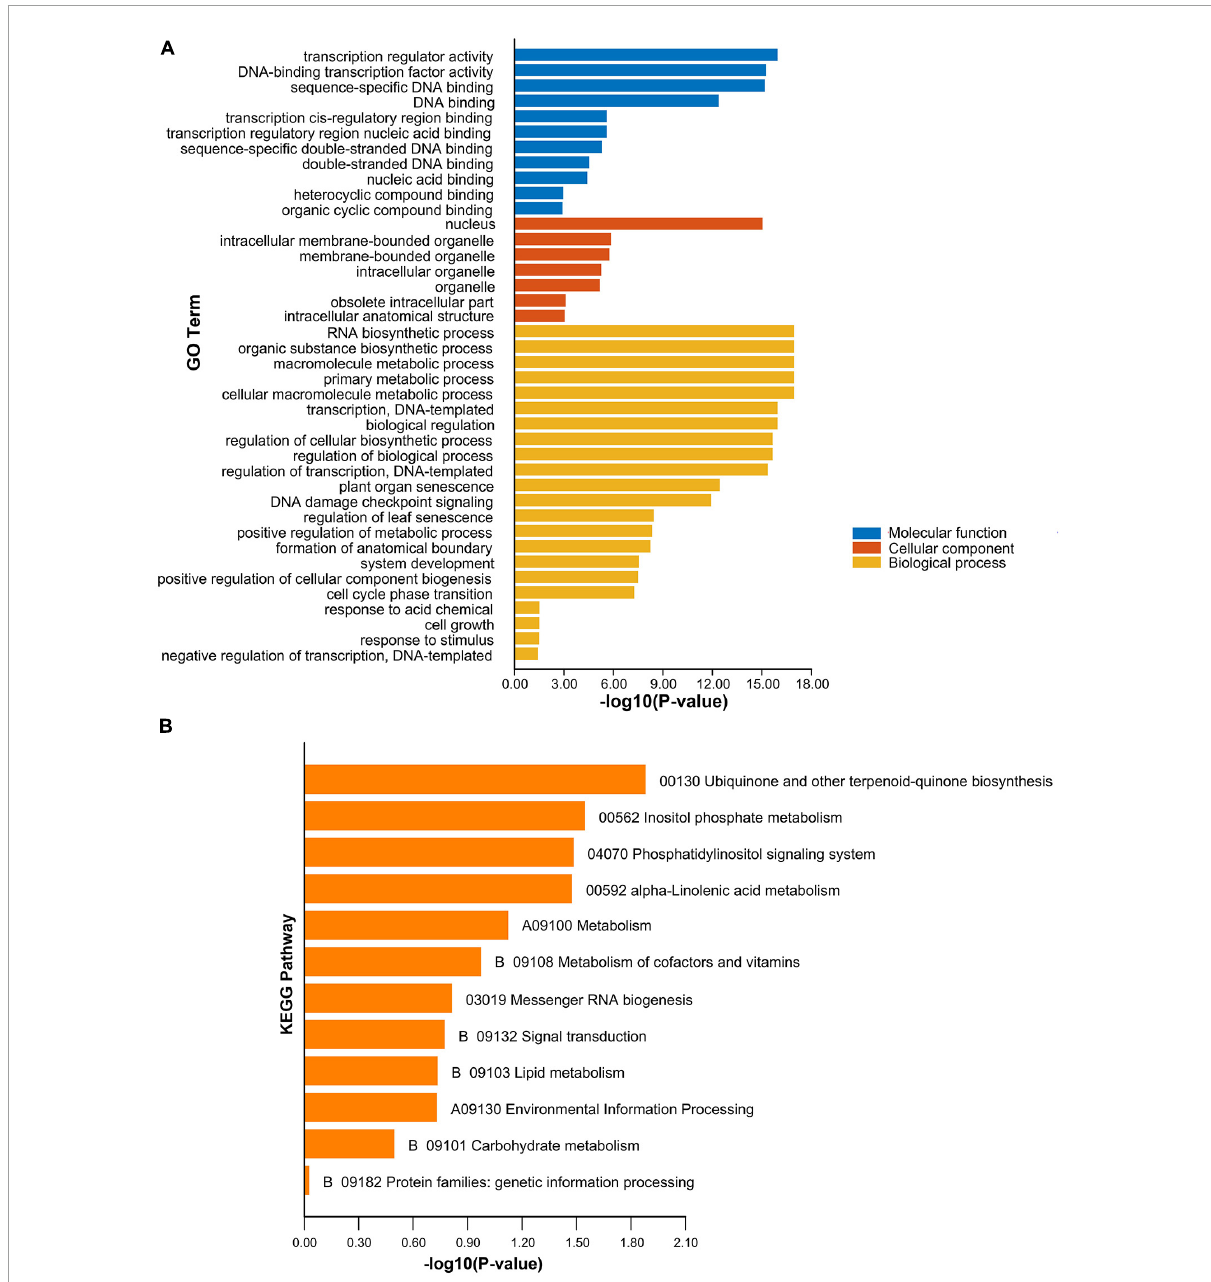
FIGURE9 Gene ontology and KEGG enrichment analysis of PeNAC genes. (A) The highly enriched GO terms in PeNAC genes. (B) The highly enriched KEGG pathways in PeNAC genes. Details about GO annotation enrichment and terms of MF, CC, BP, and KEGG pathways can be found in Supplementary Tables 11, 12